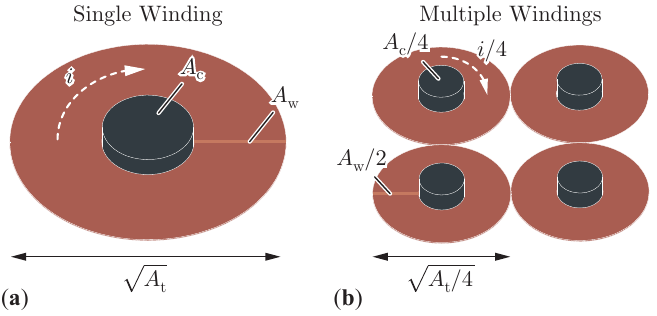
Figure 5. ( a ) Illustrative scheme of a PCB-integrated, single-turn secondary-side winding with A w window area, A c core cross-section area, A t total footprint area, and current i . ( b ) Winding-loss minimization at the expense of increased core loss by means of a multi-output (matrix) structure with paralleled windings that reduces the current density by a factor of 2 for a fixed total footprint area A t and fixed current i